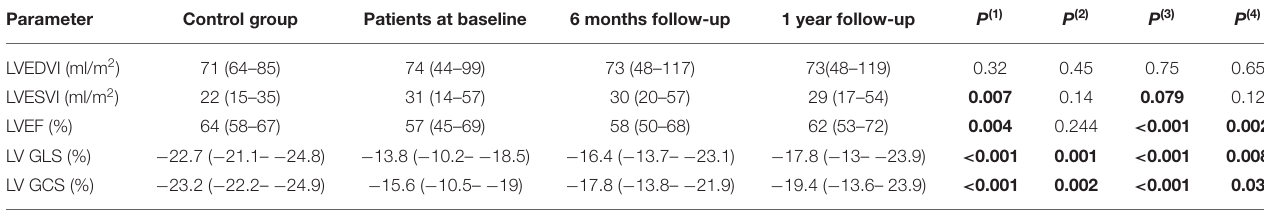
TABLE 3 | LV volumes, EF, strain and torsion values in control group and in MS patients at baseline, 6 months and 1 year after BMV. Parameter Control group Patients at baseline 6 months follow-up 1 year follow-up